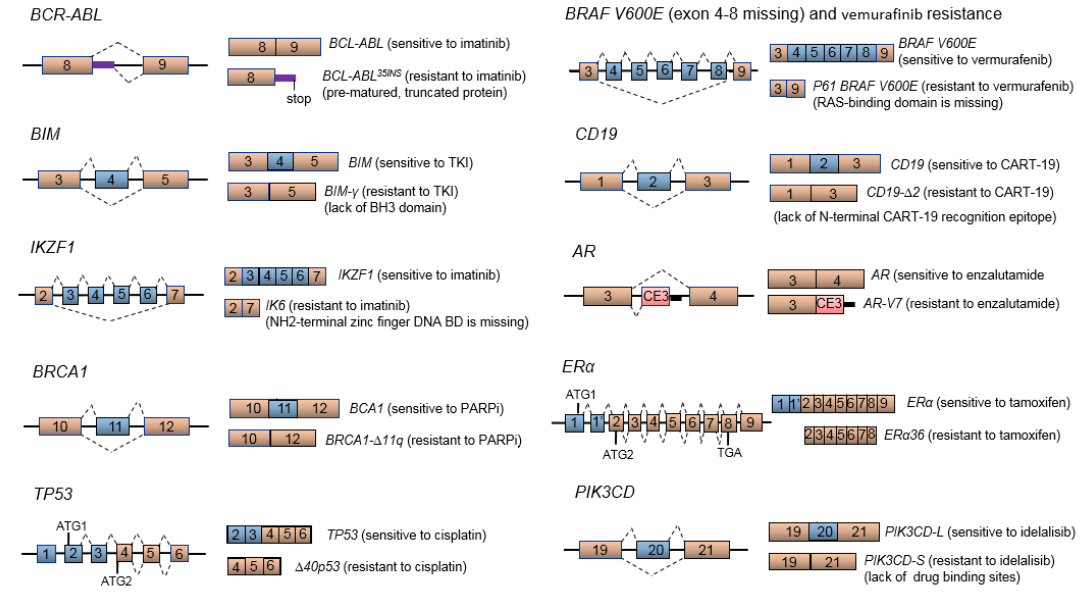
Figure 3. Aberrant mRNA splice variants in cancer drug resistance. AS events involving oncogenes, BCR-ABL , BIM , IKZF1 , BRCA1 , TP53 , BRAF , CD19 , AR , ER and PIK3CD , leading to resistance to targeted therapies, chemotherapy, hormone therapy or immunotherapy [121–127]. ATG1: Start codon for full-length TP53 and ER α . ATG2: Start codon for ∆ 40p53 and ER α 36 splice variants. TGA: Stop codon for ER α 36 splice variant. See text for additional